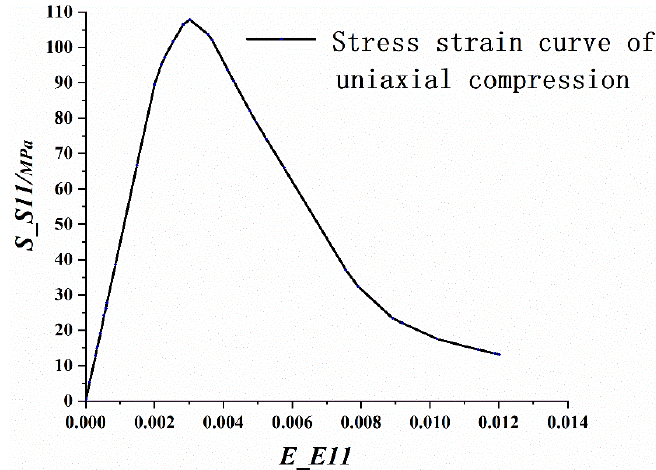
Figure 10. Longitudinal stress-strain at the edge of the midspan compression zone.